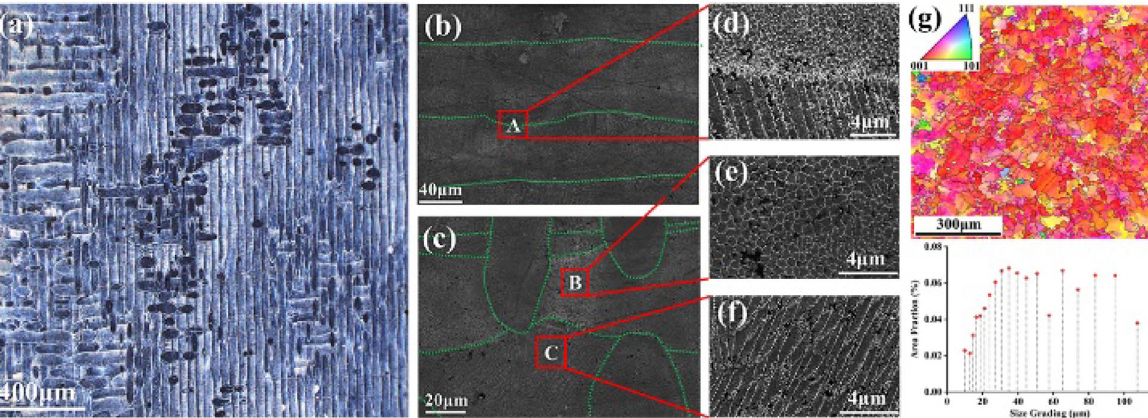
Figure 10 a The polished and etched XY surface of the SLMed sample; b Remelting area of the adjacent molten path; c Orthogonal laser scanning paths; d Region A; e Region B; f Region C; g Orientation map and size grading of the XY surface